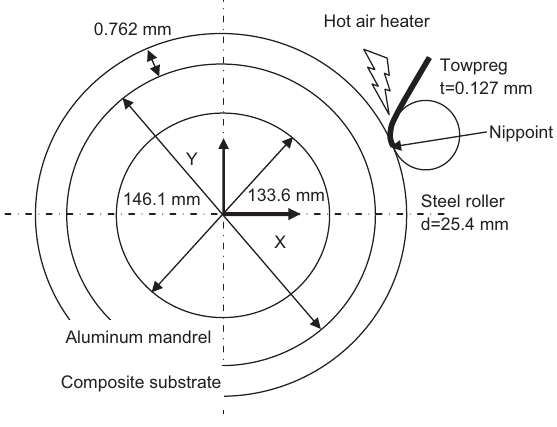
Figure 2 Geometry of the transient heat transfer of the assembly.